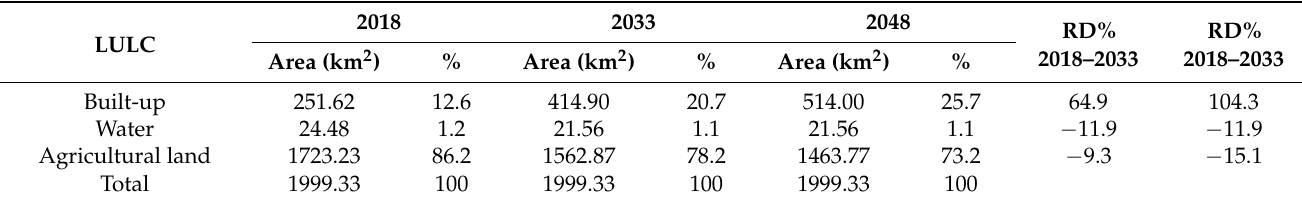
Figure 6. Projected land cover for 2033 and 2048, respectively. Table 6. The area predicted for each LULC in the study area in 2033 and